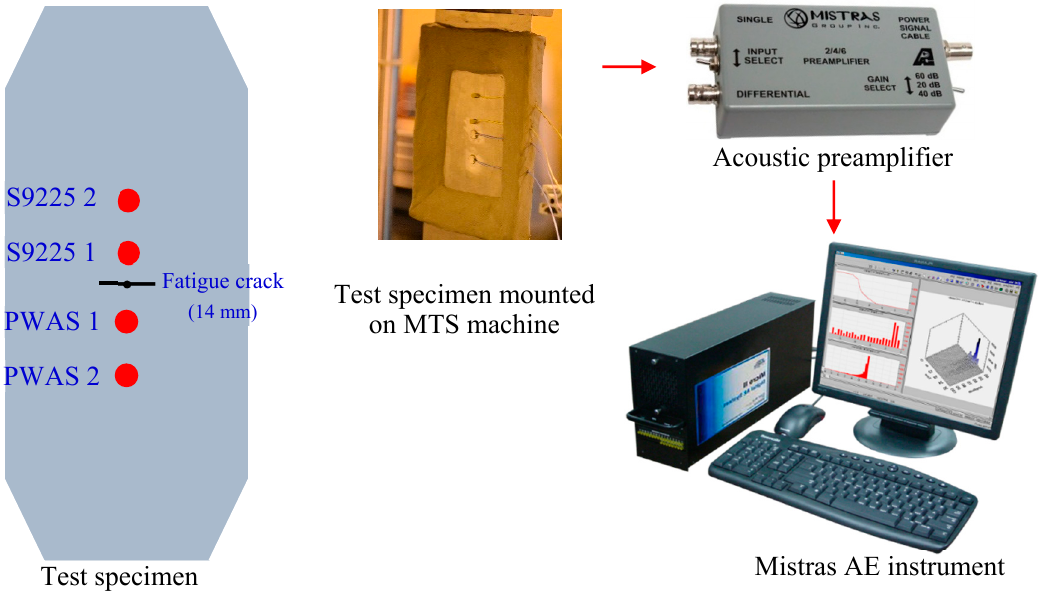
Figure 20. Experimental setup for capturing AE signals during the fatigue crack event.